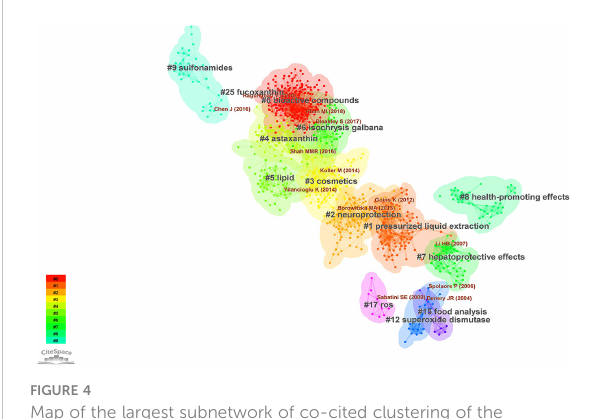
FIGURE 4 Map of the largest subnetwork of co-cited clustering of the antioxidant capacity of the bioactive substances in microalgae (Research literature from 1996 to